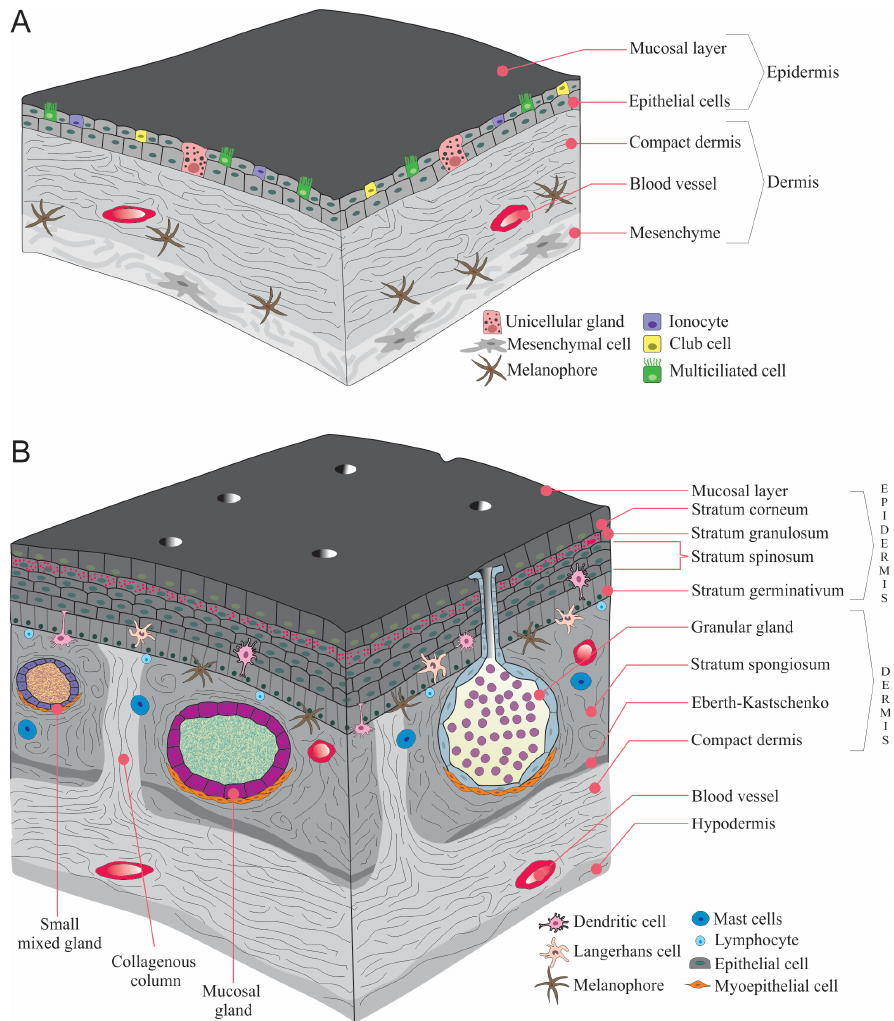
Figure 2. A general illustration of amphibian skin. A. larvae, B. Adult (B is adapted with permission from Ref. [23]. 2022, Akat et